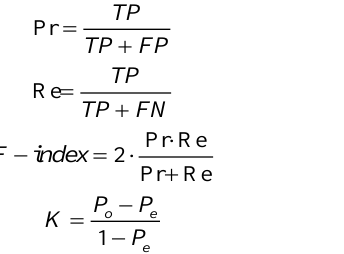
Figure 2. Four views of single plot with segmented points assigned to unique tree IDs, their positions (top left: red triangles are true positives, blue triangles false positives) and their